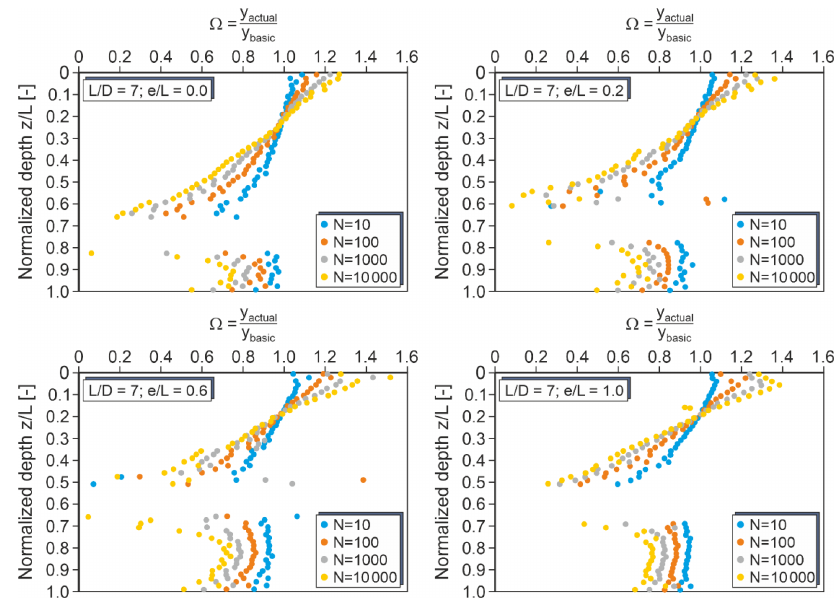
Figure 12. Correction factors (cid:127) for monopiles with L/D = 7 and different load eccentricities (very dense sand).